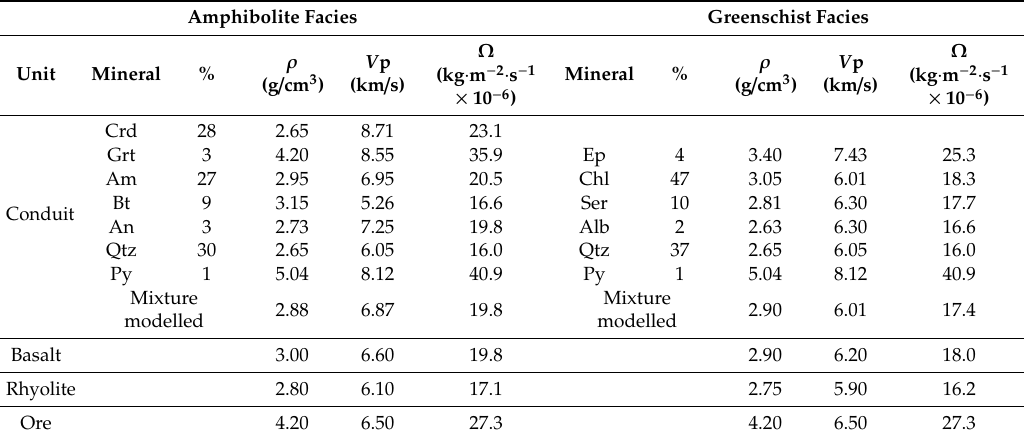
Table 8. Seismic rock properties used for synthetic modeling.